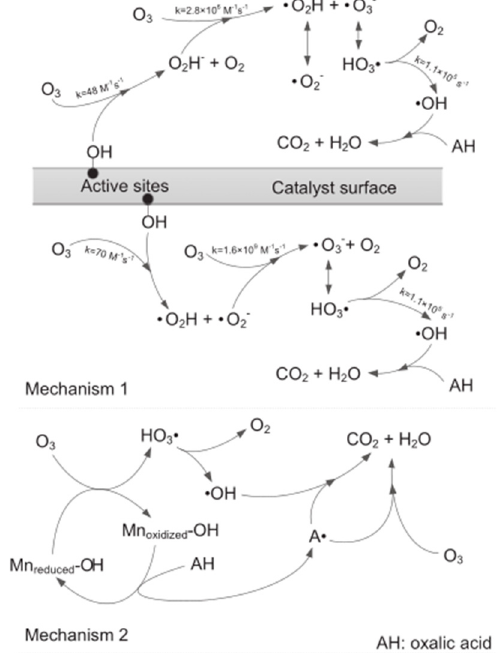
Figure 11. Mechanism of heterogeneous catalytic ozonation with MnO x /SAC.